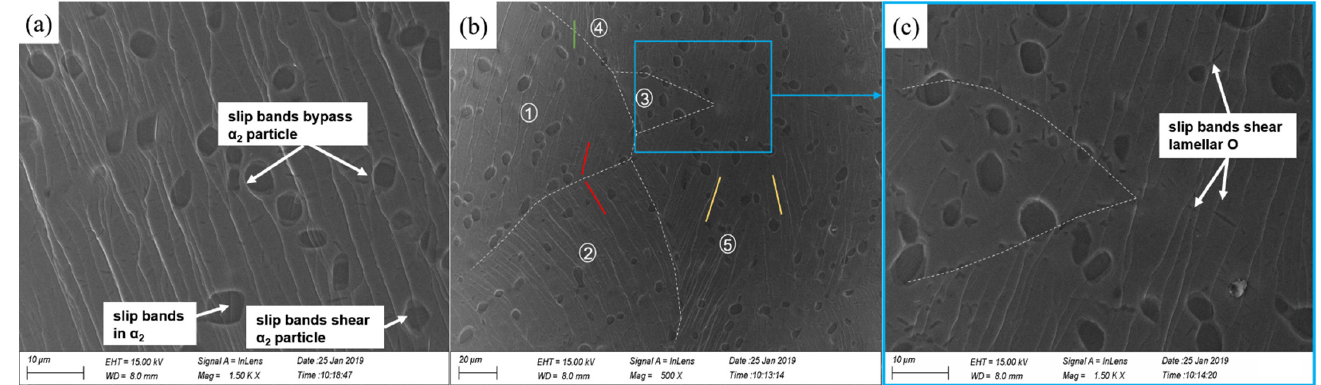
Figure 6. The morphology of slip bands at different locations of the specimen: ( a ), ( b ) the 5th stage of the stress-displacement curve; ( c ) a higher magnification of ( b ).